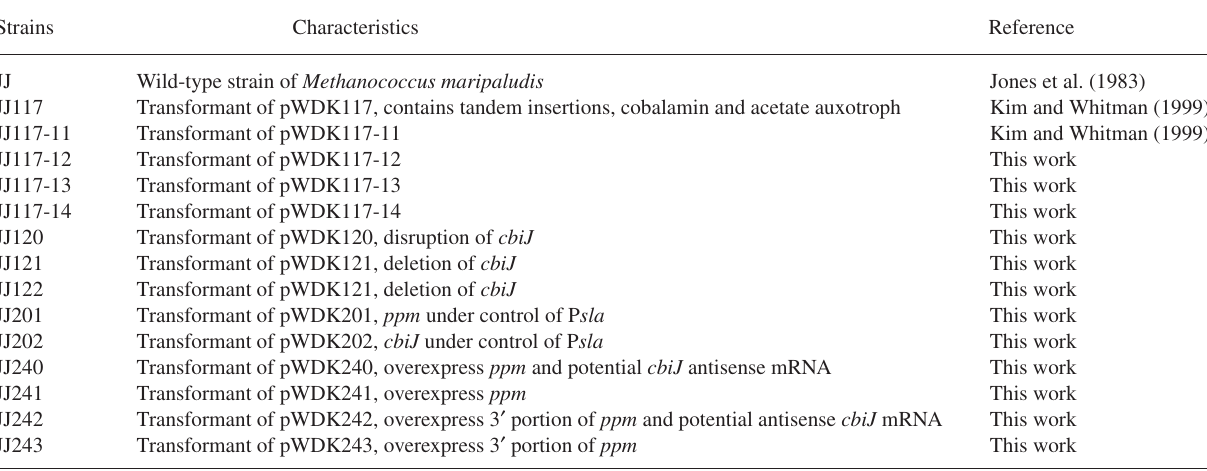
Table 2. Strains used in this study.